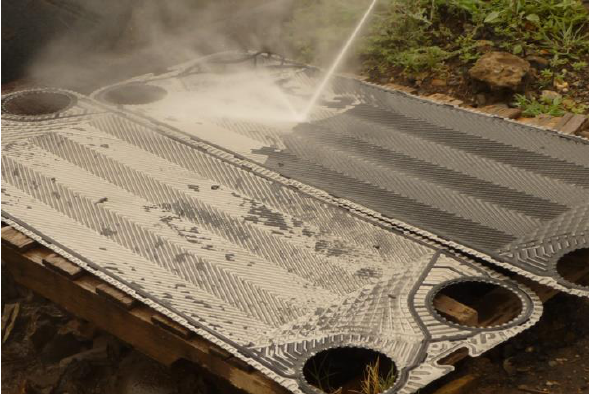
Figure 13. The cleaning process of heat exchanger plates (of a heat supply system with acoustic– magnetic devices).